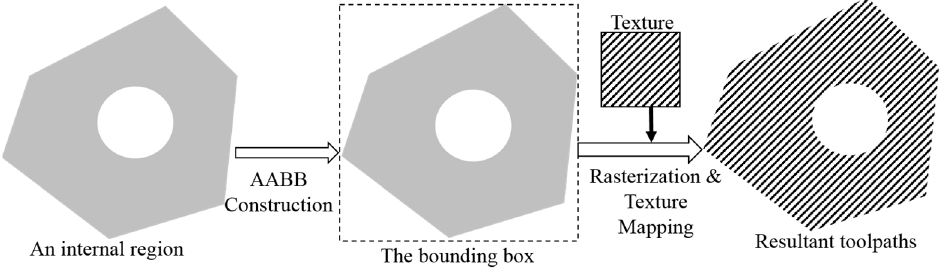
Figure 6. Internal region filling by using texture mapping. AABB, axis-aligned bounding box.